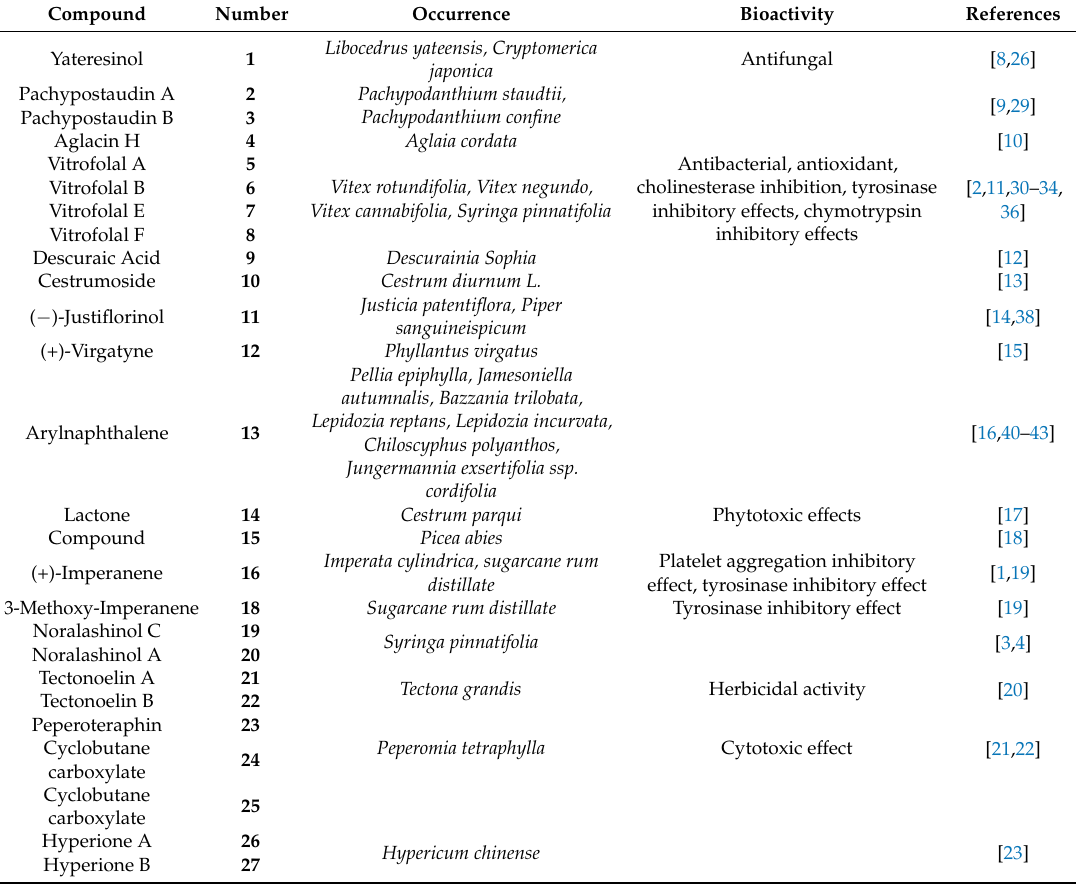
Table 1. 9-Norlignans, their occurrence and biological